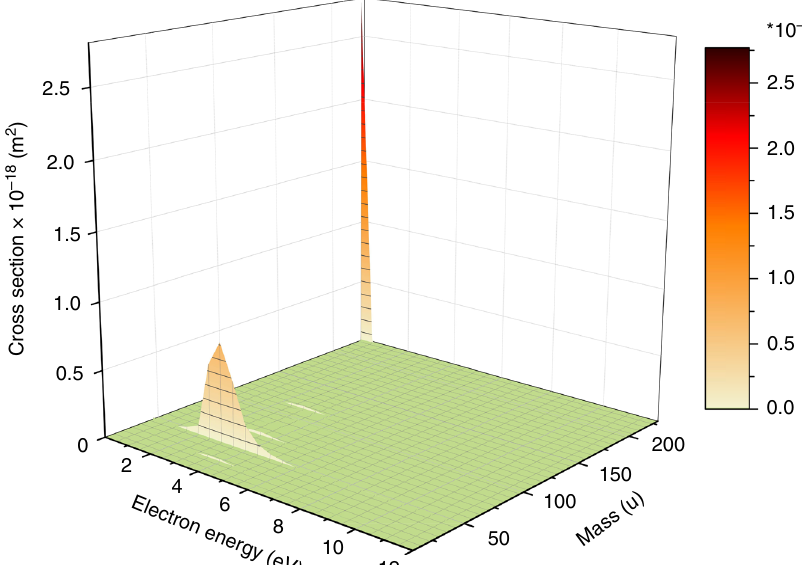
Fig. 2 Intensity map of (fragment) anions formed upon electron attachment to nimorazole. The map shows cross-sections derived from negative ion mass spectra recorded in the interval of 0.5 eV for the electron energy range between ~0 and 12 eV. Only two abundant anions can be observed, (i) the radical anion at mass 226 u close to zero eV (see Fig. 1), and (ii) the nitrite NO 2 − at mass 46 u, which is abundantly formed only in the region between 2 and 4 eV. Source data are provided as a Source Data fi